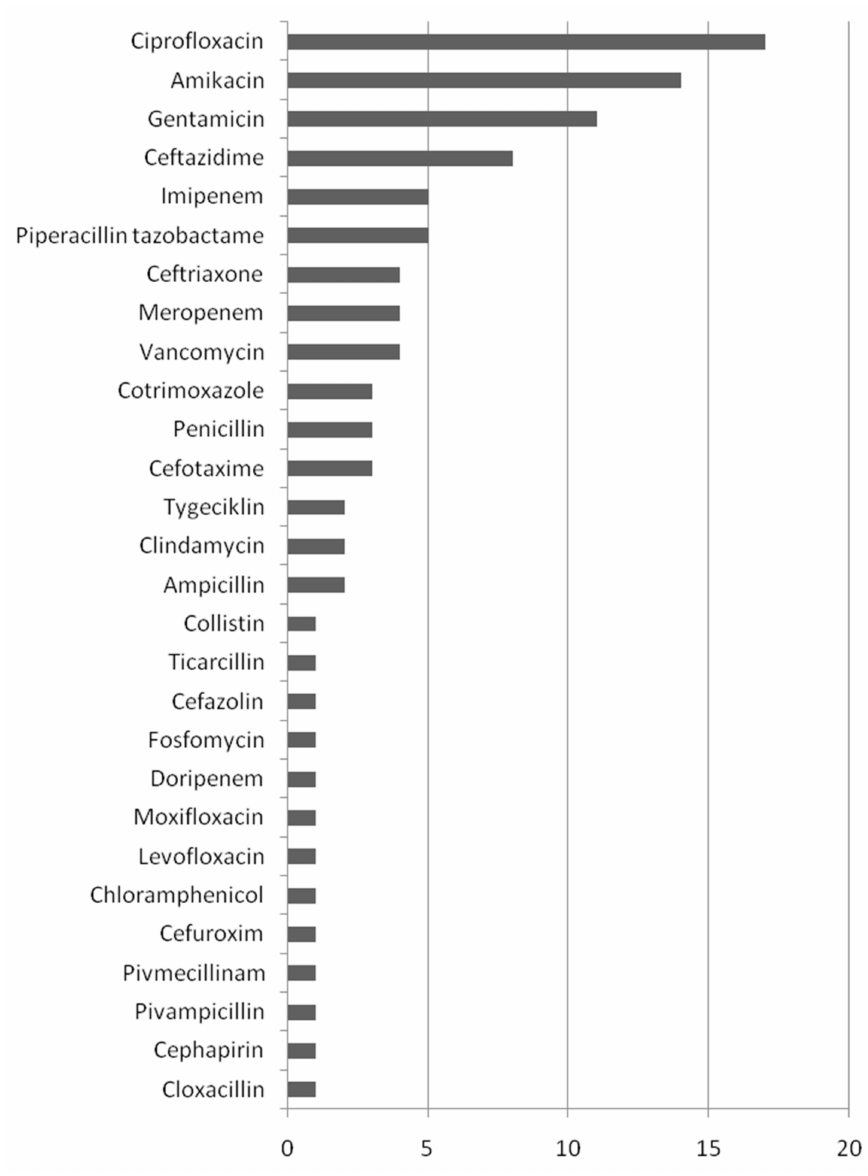
Figure 3. Antibiotics used for the treatment of S. marcescens